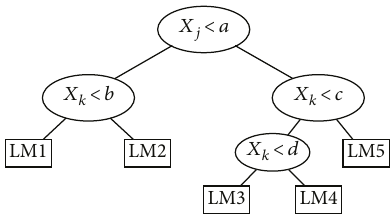
Figure 1: Typical architecture of a simple regression tree. LMs: linear